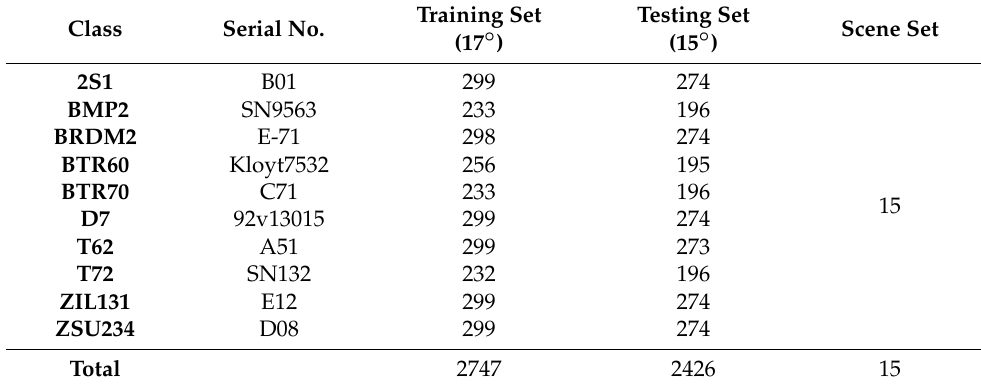
Table 2. Data description for SOC.